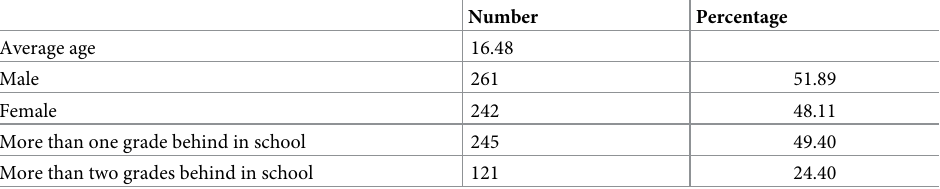
Table 2. Sample characteristics.